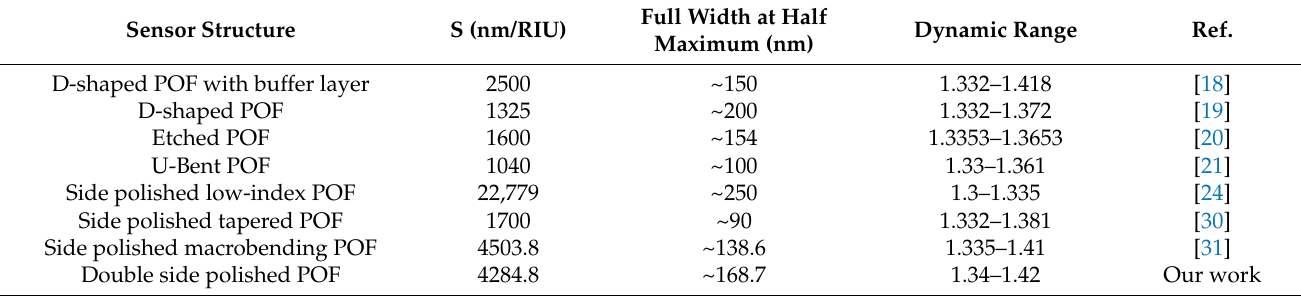
Table 1. Performance comparison for different types of plastic optical fibers (POFs)-based surface plasmon resonance (SPR)